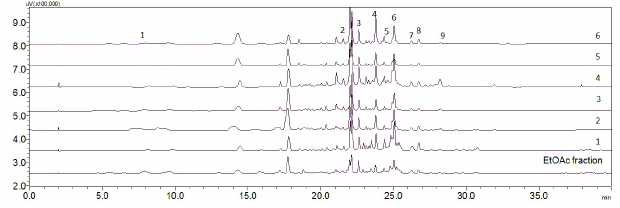
Fig 1. Chromatograms (HPLC-DAD 320 nm) of the phenolic fractions of Melipona subnitida geopropolis (1-6) and of EtOAc fraction geopropolis collected in January 2010. Compounds identified were: 6- O - p -coumaroyl- D - galactopyranose ( 1 ), 6- O -cinnamoyl-1- O - p -coumaroyl-β- D -glucopyranose ( 2 ), 7- O -methyl naringenin ( 3 ), 7- O -methyl aromadendrin ( 4 ), 7,4’-di-